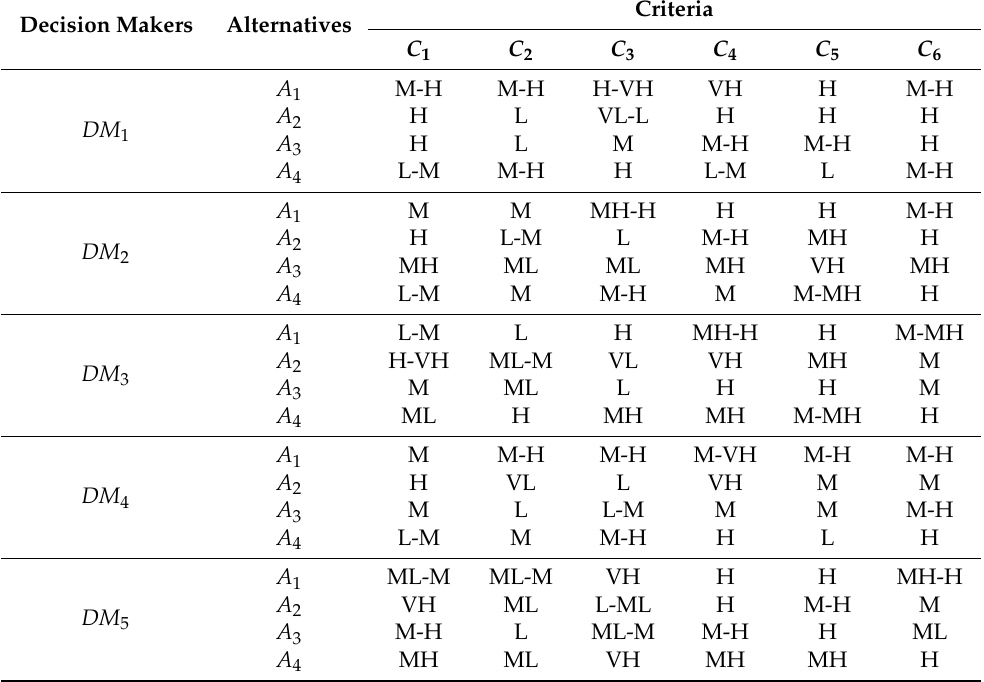
Table 1. Linguistic assessments of the HCW treatment alternatives.